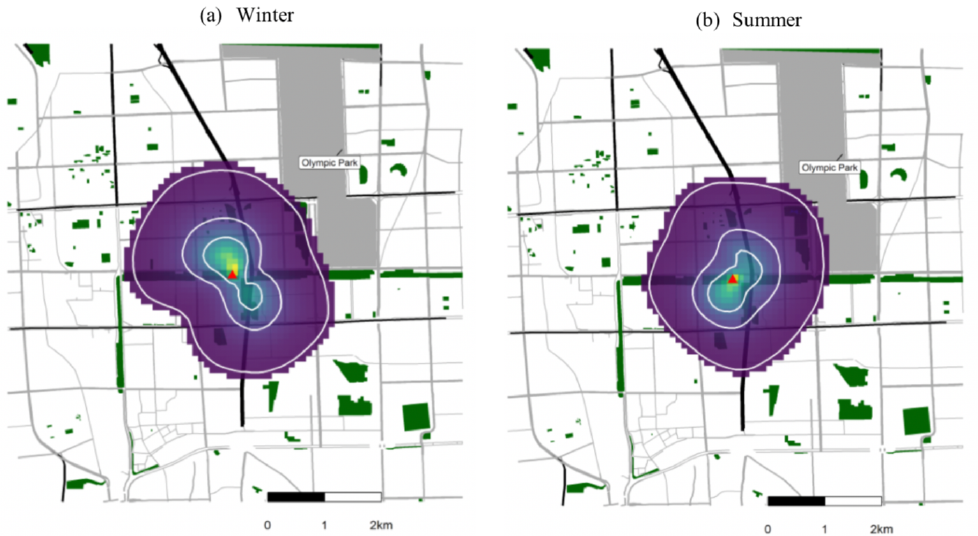
Figure 7. Total average mass flux footprints for winter and summer seasons. The red spot on each plot is the location of the IAP tower, and surrounding colours represent the magnitude of the intensity of the measured emission. The resolution of footprint is 100m 2 , the outermost white line represents the 90% cumulative spatial contribution of the total flux and the middle and the innermost lines represent 60% and 30% contribution. Map was built using data from © OpenStreetMap contributors 2020. Distributed under a Creative Commons BY-SA License. The ring roads are shown in black, and other roads are shown in grey. Parks/green spaces are shown in green.